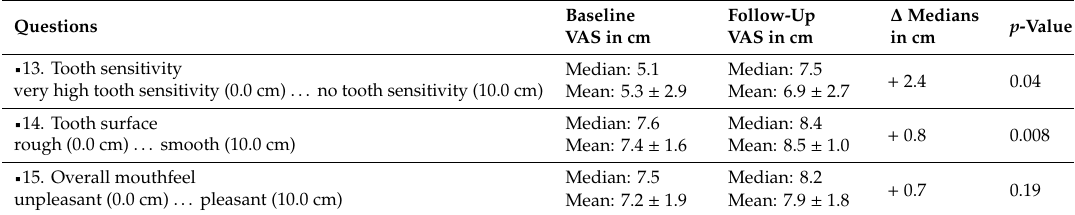
Table 3. Subjective parameters related to tooth sensitivity, tooth surface, and overall mouthfeel; baseline and follow-up (4-week) data (VAS = visual analogue scale).